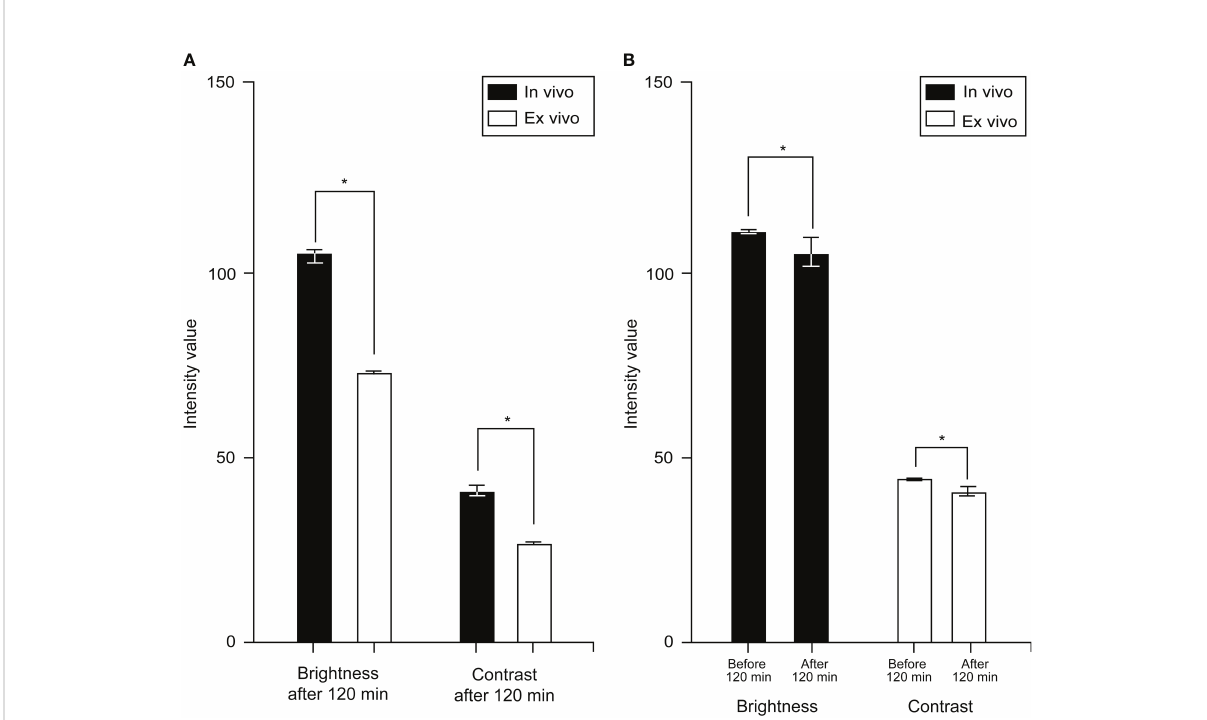
FIGURE 5 Bar chart showing mean (SD) brightness and contrast of images acquired at different time intervals after fl uorescein sodium (FNa) dosing. (A) Comparison of images acquired later than 120 min after FNa dosing in both studies; the mean brightness ( in vivo vs. ex vivo : 105.1 [18.9] vs. 72.4 [24.9], p < 0.001) and contrast ( in vivo vs. ex vivo : 41.7 [8.7] vs. 27.1 [8.5], p < 0.001) of the in vivo images are signi fi cantly higher than those of the ex vivo images. (B) Compared to the images acquired earlier than 120 minutes after FNa dose, the images acquired later than 120 minutes had a slight decrease in brightness (112.2 [27.0] to 105.1 [18.9], p < 0.001) and contrast (44.74 [8.0] to 41.07 [8.6], p < 0.001). Values are reported in optical density units de fi ned by Fiji software. Asterisk indicates p < 0.001. Used with permission from Barrow Neurological Institute, Phoenix, Arizona